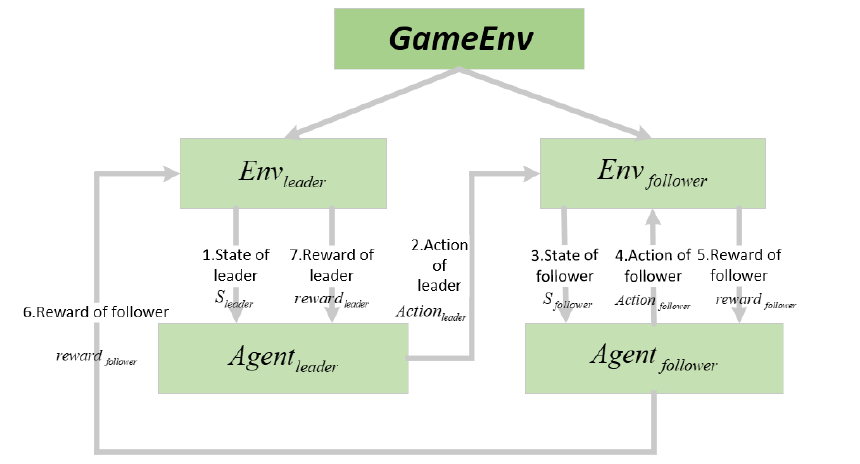
Figure 3. Stackelberg–MADDPG algorithm